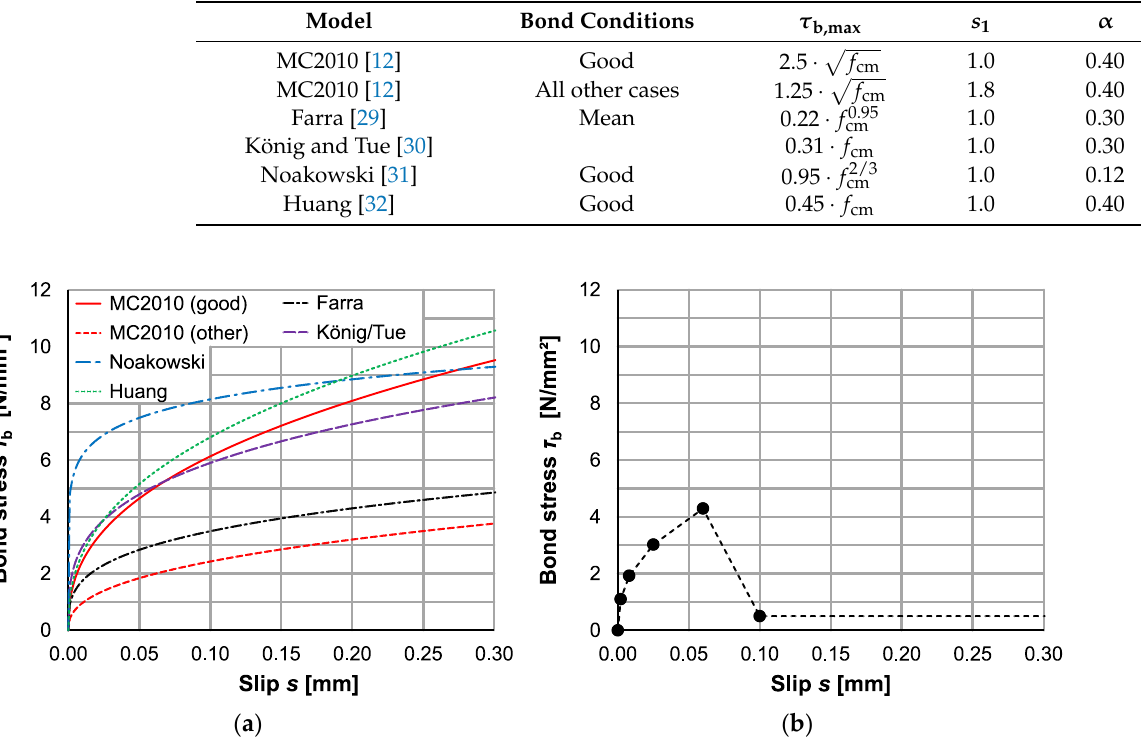
Figure 10. Bond laws: ( a ) according to Equation (14) and Table 1; ( b ) user-defined. Even if the real bond behaviour differs significantly from the bond–slip relationship in Equation (14), user-defined bond–slip relationships can be defined in the CPM using slip values and the corresponding bond stress values. Between the points, a linear interpolation is used to determine the missing values. The only prerequisite here is the starting point at the coordinate origin ( τ b ( s = 0) = 0). An exemplarily user-defined bond–slip relationship is where: λ ( x ) is the factor for a reduction of the local bond stress at distance x from the shown in Figure 10b for a splitting separation crack; x is the distance from the crack; and τ b ( s ) is the local bond stress (e.g., according to Equation (14)).